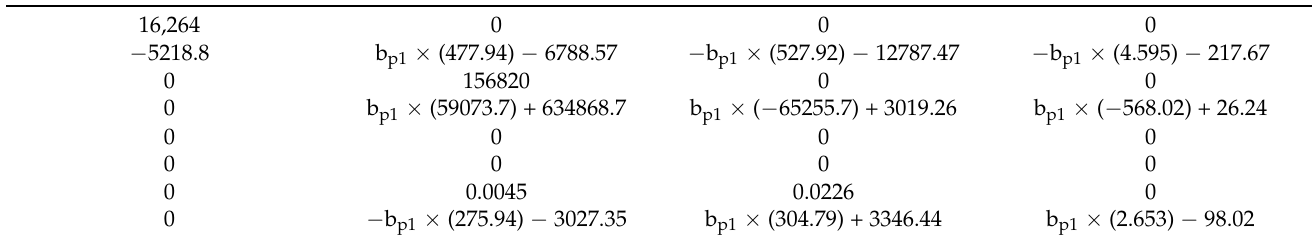
Table A2. The functional relations of 5–8 Column elements of matrix A with respect to h p3 and b p1